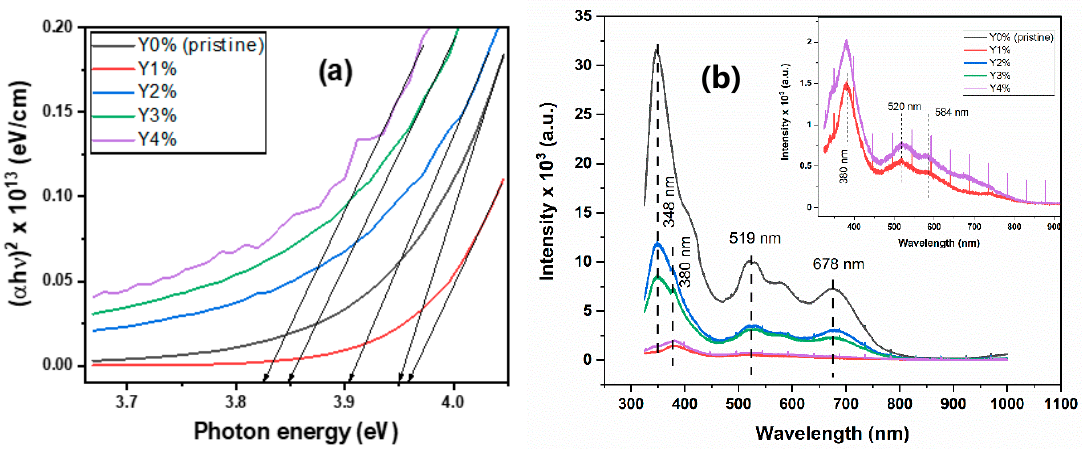
Figure 3. ( a ) Energy bandgap and ( b ) PL spectra of pristine and composite.